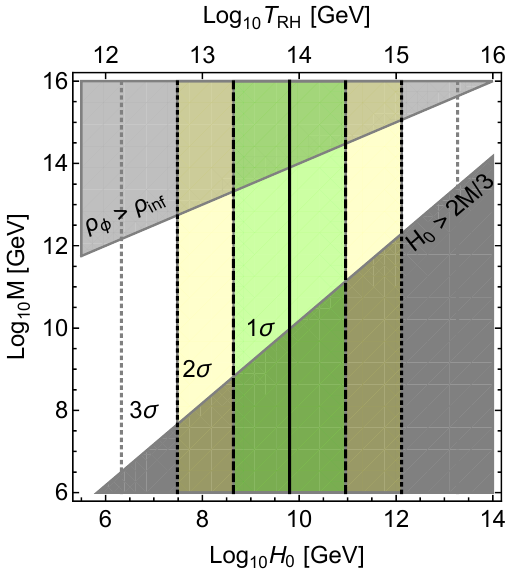
Figure 8 . The region of H 0 (the Hubble rate during inflation) and M (the energy cutoff of the Higgs sector) in which the SOL prediction is consistent with the SM values of the Higgs and top- quark masses at the 1- σ to 3- σ levels. Also shown are the corresponding values of the reheating temperature T . In the shaded regions, the apeiron energy density exceeds the inflationary back- RH ground ( ρ ) or quantum fluctuations destabilise the UV phase ( H φ > ρ inf